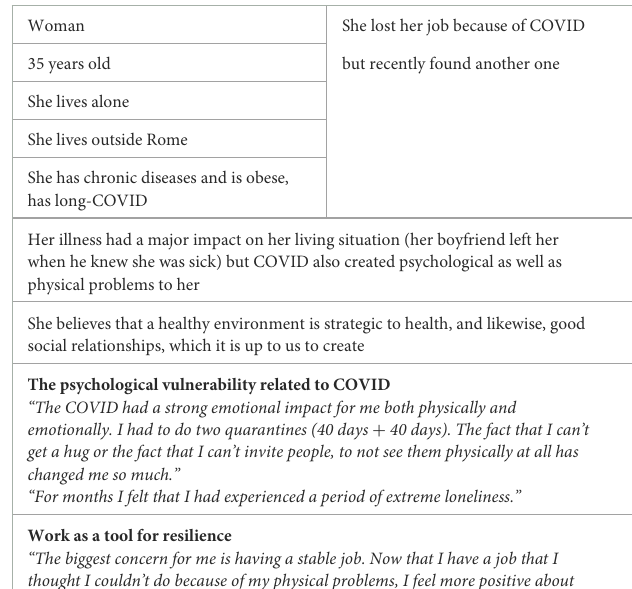
TABLE 5 The woman with chronic diseases and